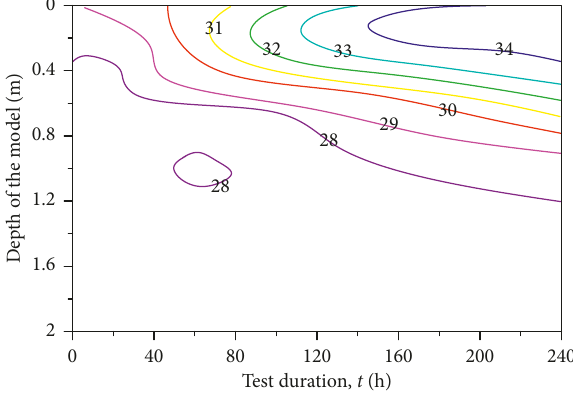
Figure 7: Time history of the water content in